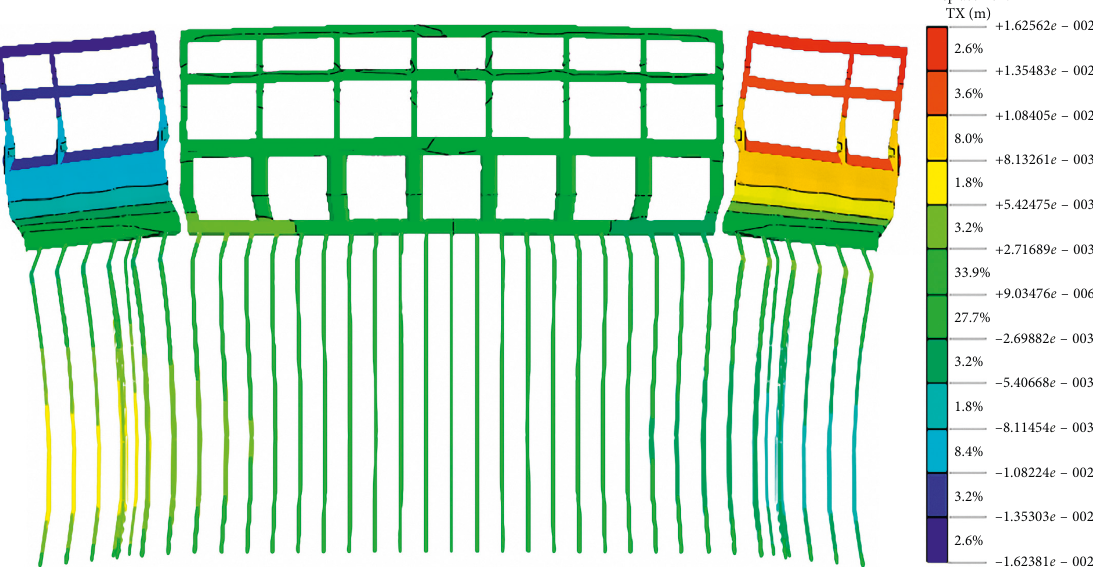
Figure 18: Magnified deformation of the sluice structure and pile (consolidation degree is